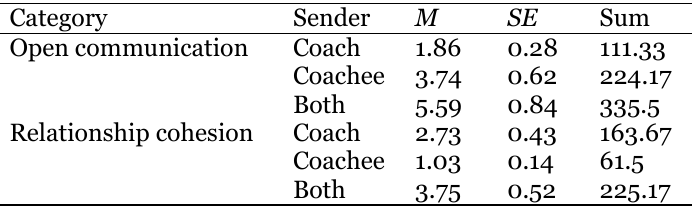
Descriptive statistics for Social Presence Category Sender Open